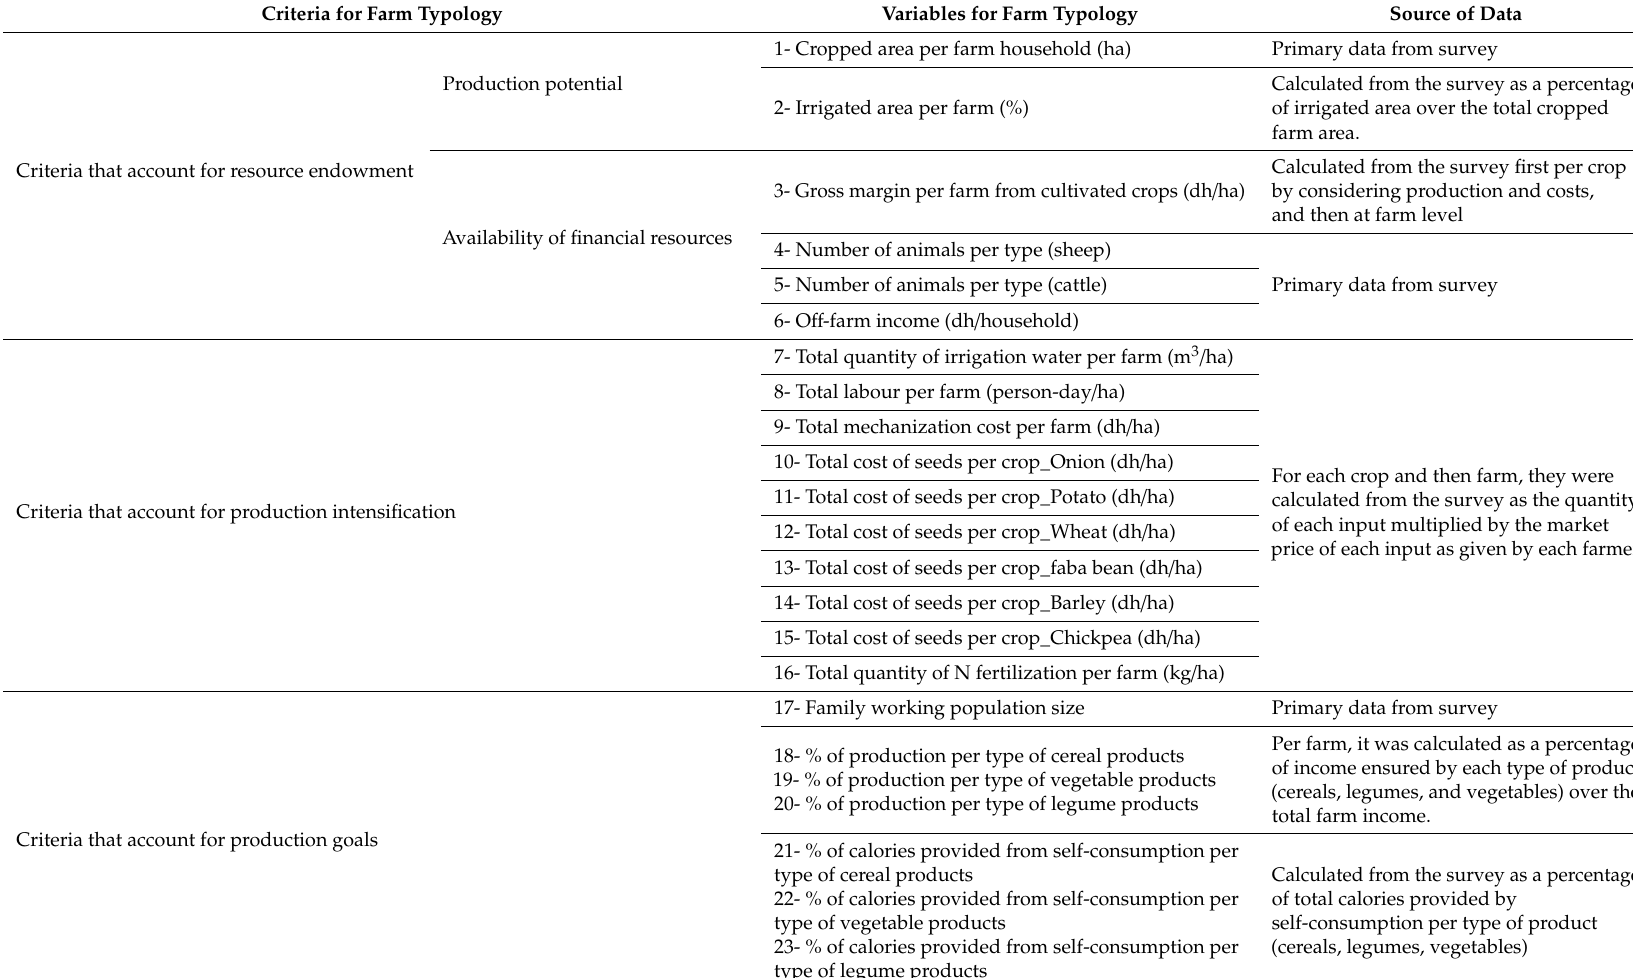
Table 1. Criteria and variables used for identifying distinct farm household